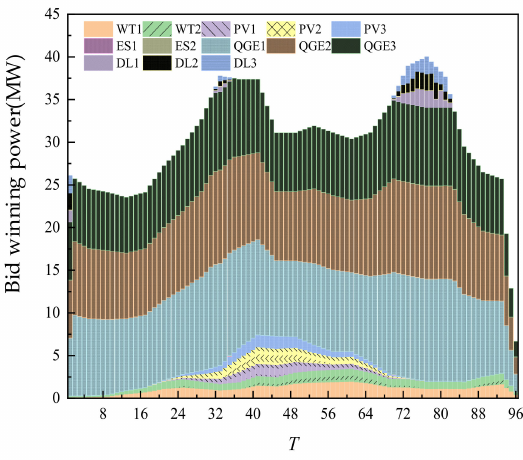
Figure 5. Overall trading of SGLS.